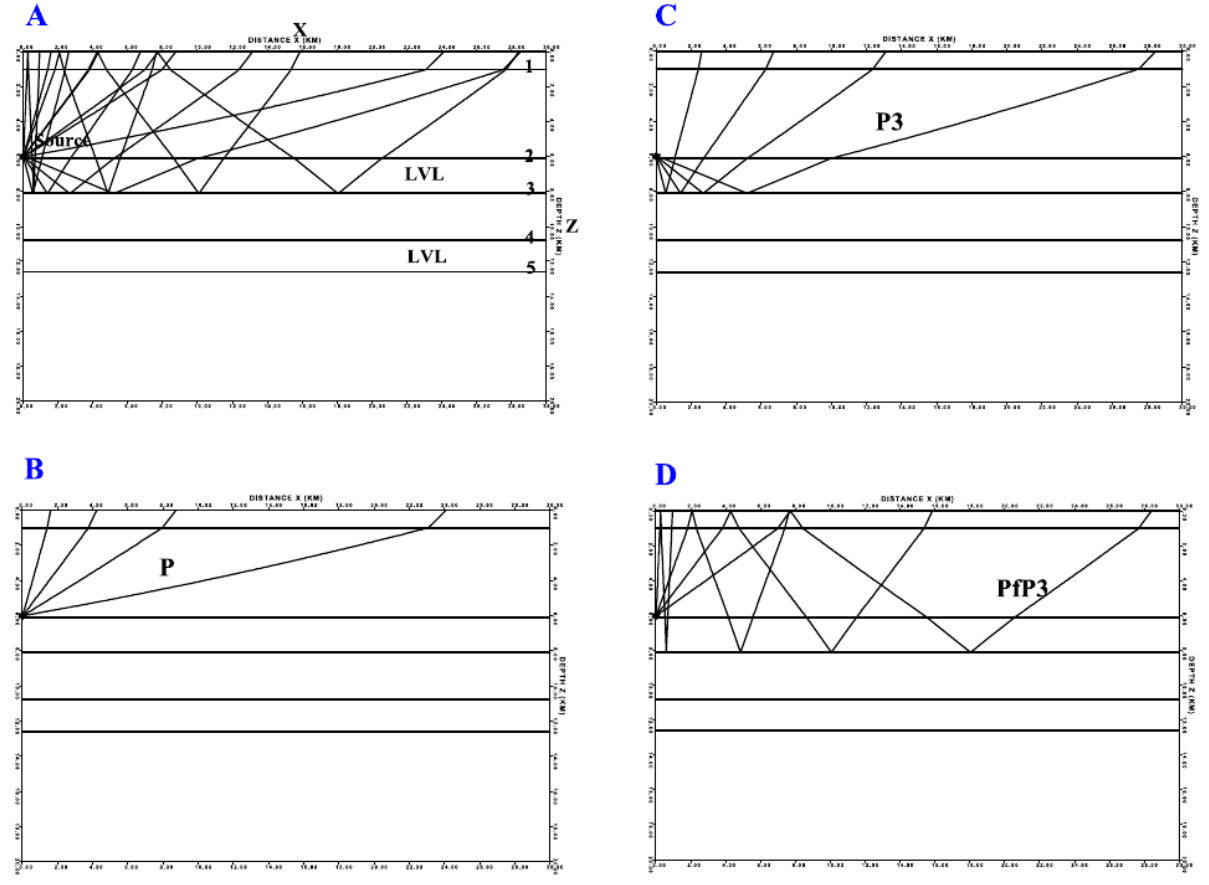
Figure 11. Schematic ray diagram illustrating the ray paths of prominent wave types considered for computing the P and S travel time curves given in Figures 9a and 10a. A : illustrates the upper crustal model, B : illustrates the ray paths for P (or S), C : illustrates the ray paths for Pi (or Si), and D : illustrates the ray paths for PfPi (or